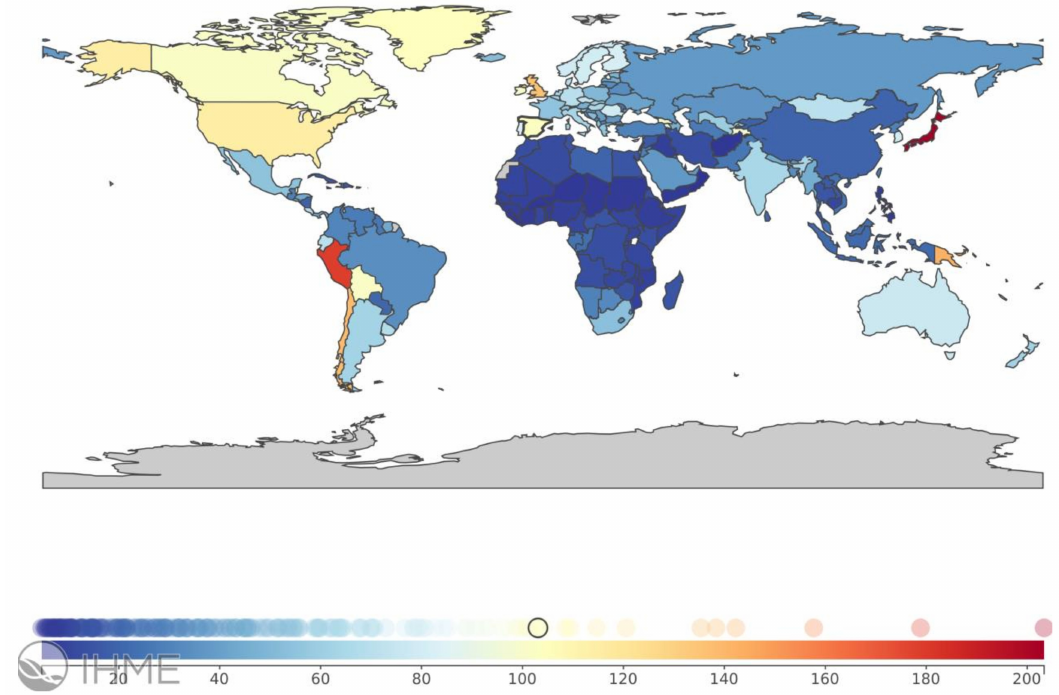
Figure 1. Worldwide burden of interstitial lung diseases and pulmonary sarcoidosis, measured in disability-adjusted life years (DALYs) per 100,000 in 2016, all ages, both sexes, by country. From https://vizhub.healthdata.org/gbd-compare/ (open web site, accessed on 14 July